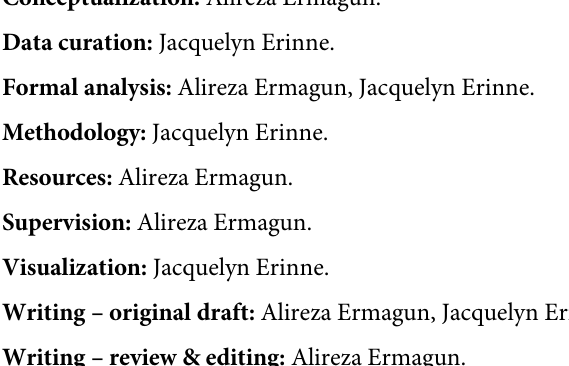
S2 Table. All Engineering program rankings and financial